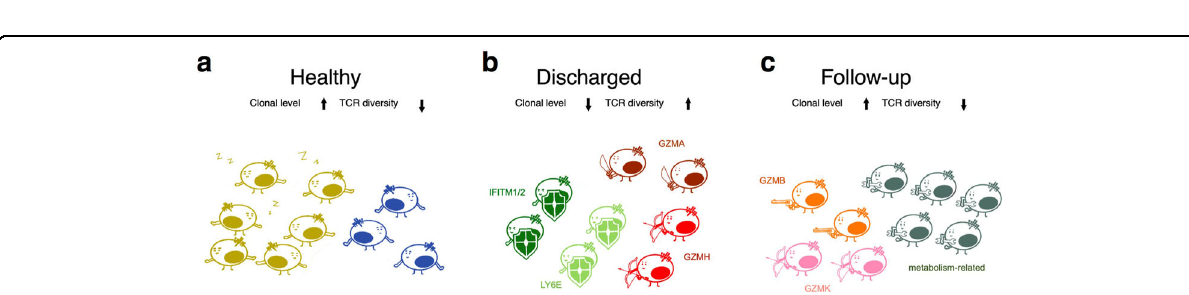
Fig. 7 A model for CD8 + T cell immune dynamics in recovered COVID-19 patients. a The minor clones of CD8 + T cells in HD group were the immune surveillance cells with high clonal expansion level and low TCR diversity. b CD8 + T cells of Discharged group were minor clones with low clonal expansion but high TCR diversity, which displayed powerful defending and cytotoxicity effects via interferon- and granzyme-related genes ’ expression. c In the Follow-up group, CD8 + T cells remained a few minor clones of cytotoxicity and large clones with active metabolic reprogramming. Different colors of T cells represent they are from different clones. Weapons and shields on T cells represent that T cells express functional genes for killing the infected cell and defending themselves from SARS-CoV-2 infection,